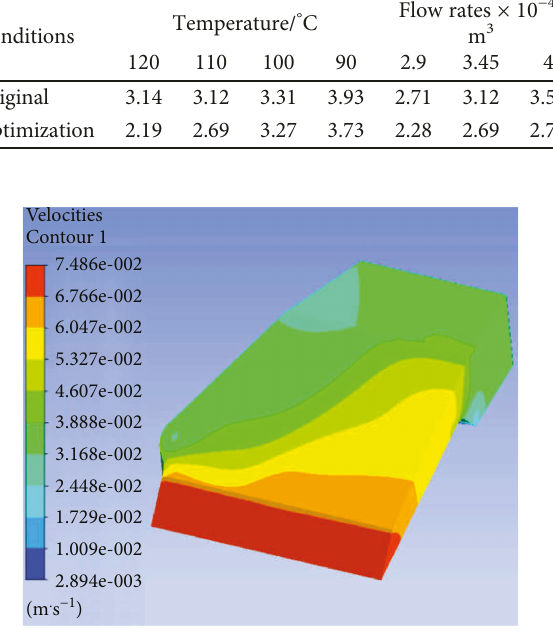
Figure 9: Rubber fl ow velocity in optimized runner at 110 ° C and